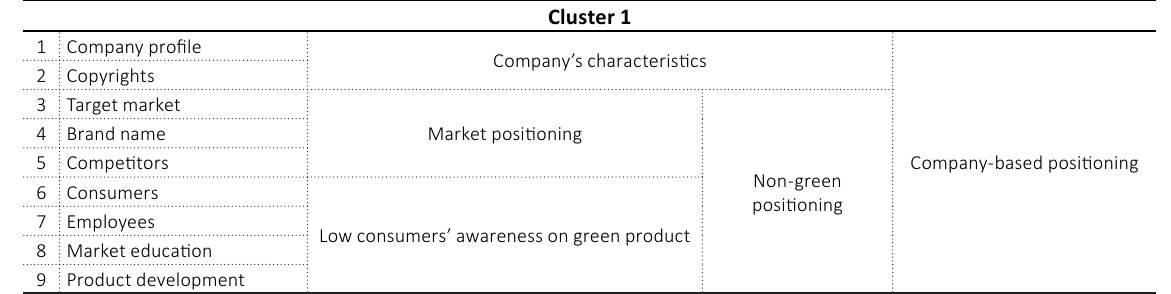
Table 2. Codes comprising Cluster